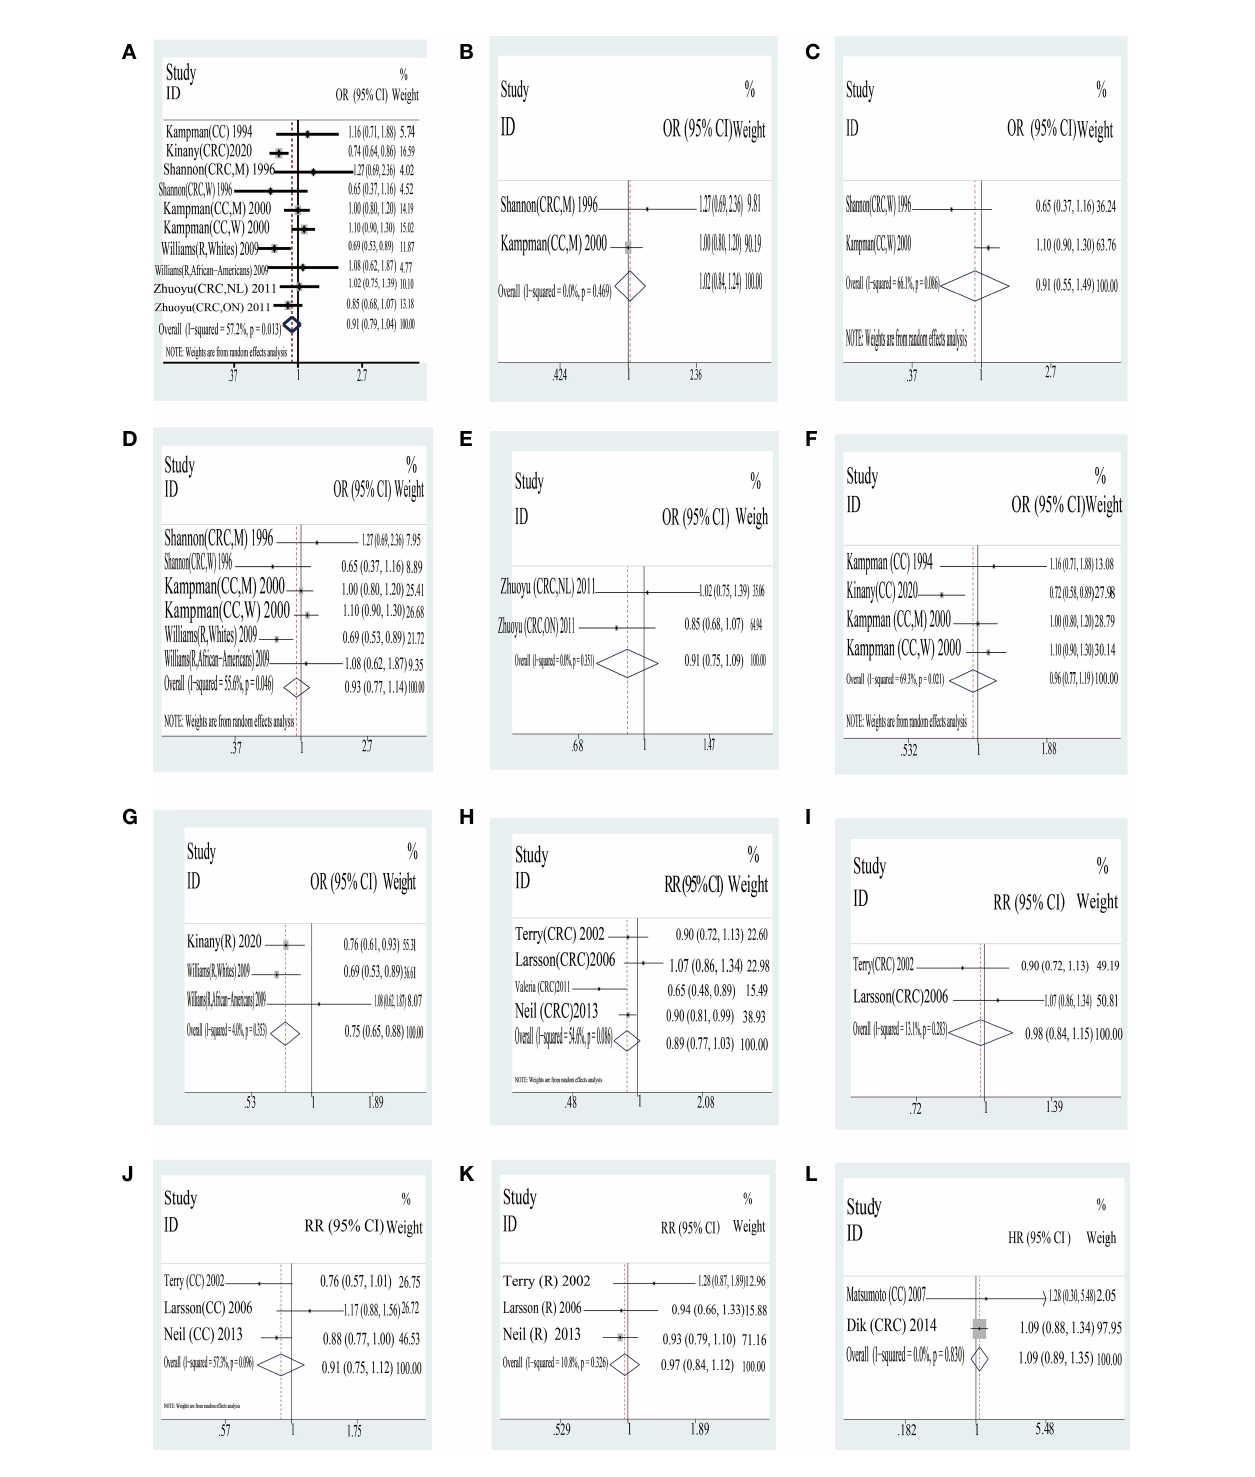
FIGURE 2 | Yogurt: forest plot of case – control studies (A – G) and cohort studies (H – K) in yogurt examining the association between consumption of yogurt and risk of colorectal cancer as well as the consumption of yogurt in the mortality of colorectal cancer (L) . CRC, colorectal cancer; CC, colon cancer; DC, distal colon cancer; R, rectal cancer; M, man; W, woman; NL, subjects in Newfoundland and Labrador; ON, subjects in Ontario. Case – control studies: (A) total CRC; (B) CRC in man; (C) CRC in woman; (D) US; (E) Canada; (F) colon cancer; (G) rectal cancer; Cohort studies: (H) total CRC; (I) Sweden; (J) colon cancer; (K) rectal cancer; (L) mortality of